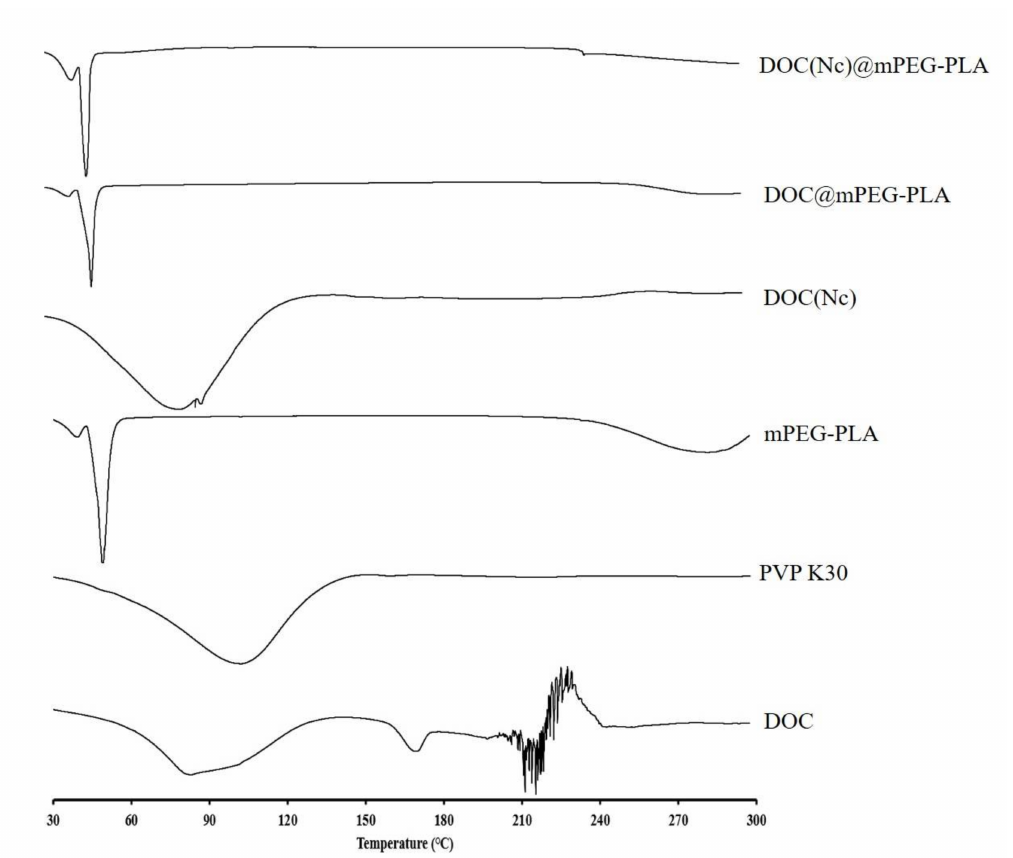
Figure 5. The DSC spectra of different materials.